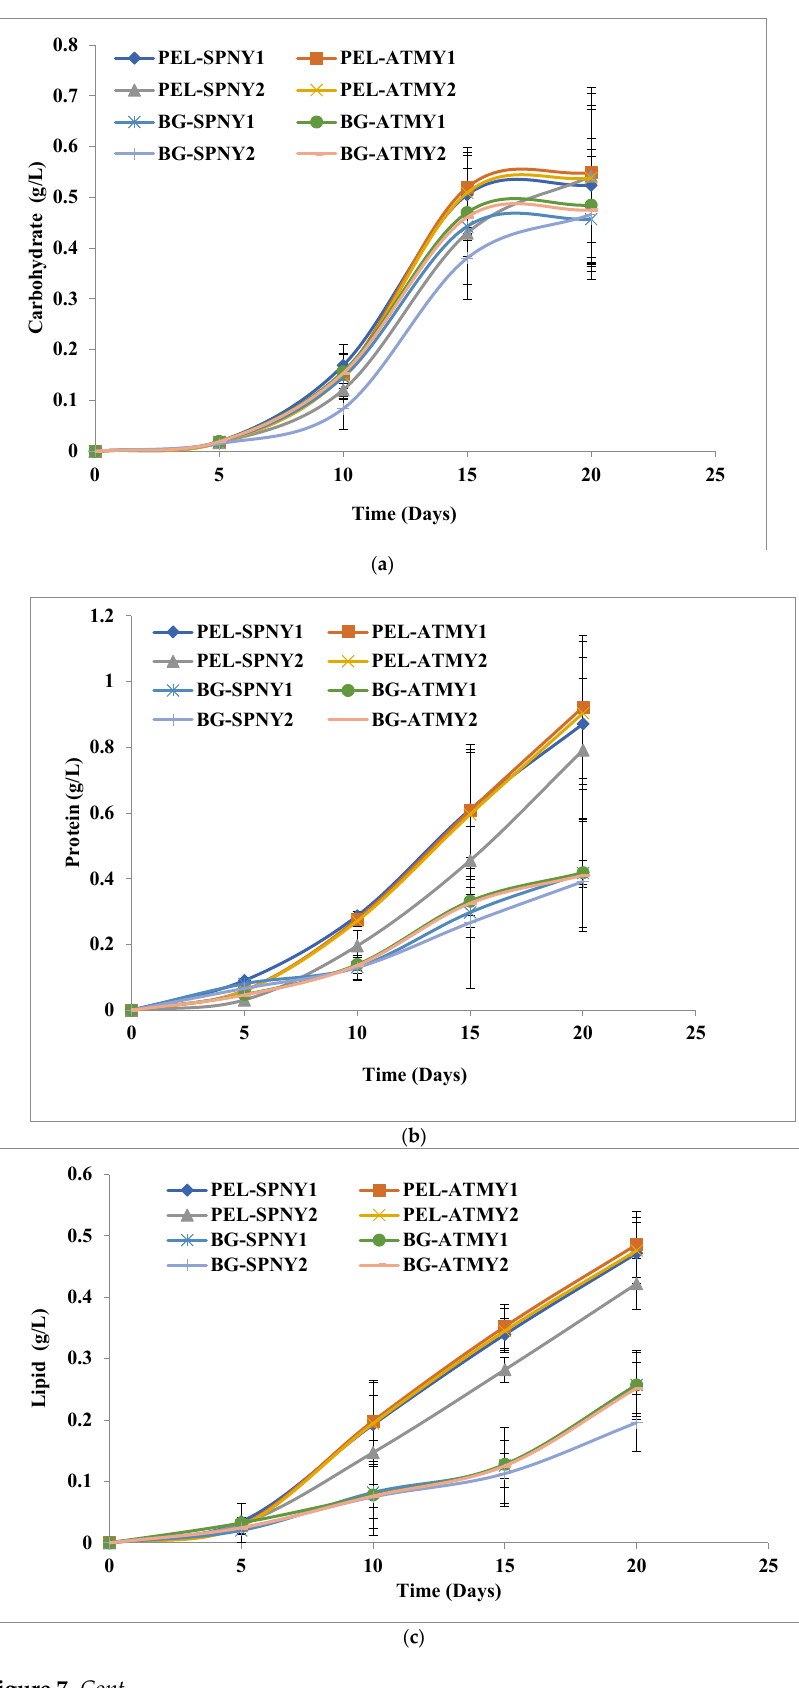
Figure 6. Growth of C. pyrenoidosa at solar inclination angles of 47.9°.